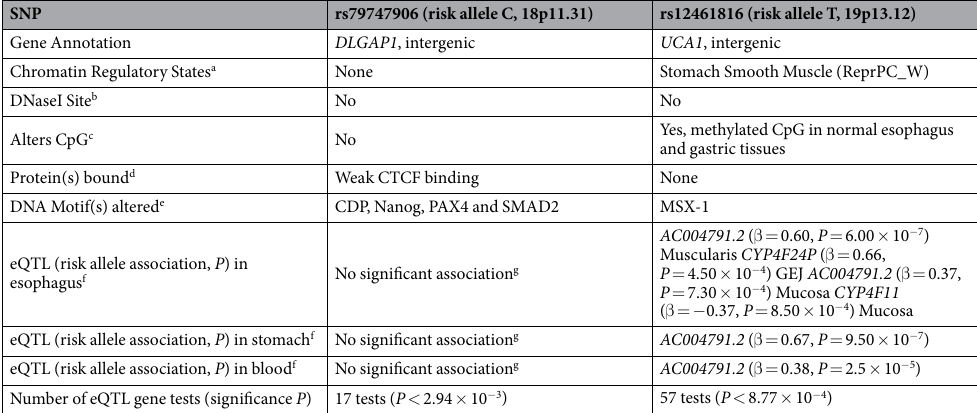
Rs79747906 is located in the intergenic region close to DLGAP1 , SNPs of which have been associated with obsessive-compulsive disorder 19 . Based on Roadmap Epigenomics data rs79747906 does not appear to map to a regulatory region in normal UGI tissues or blood, but the C allele, which was positively associated with FH, overlapped with a weak CTCF binding function in ENCODE cells including Human Esophageal Epithelial Cells (HEEpiC) (Table 3 and SI Figure 1). However, we did not observe potential regulatory function for any SNPs in LD with rs79747906 (r 2 ≥ 0.40, http://analysistools.nci.nih.gov/LDlink/) in normal esophageal tissue (data not shown). We also found that the rs79747906 C allele may alter several DNA binding motifs of homeobox tran- scriptional factors and proteins, including CDP, Nanog, PAX4, and SMAD2 (ENCODE and HaploRegv4) and scores high as a regulatory SNP for embryonic stem and progenitor cells of other tissues (RegulomeDB and HaploRegv4). Collectively, these findings suggest that the genetic region containing rs79747906 has the potential to change chromatin architecture in esophageal epithelia and/or in esophageal stem cells via protein binding. Our eQTL analysis of rs79747906 C allele showed only suggestive and tissue-specific evidence of a potential cis -eQTL effect on transcription, such as increased expression of LPIN2 (more distal protein coding gene) in blood and RP13-270P17.3 (a long intergenic non-coding RNA [LincRNA] gene) in stomach mucosa. It is worth noting that metabolic changes have been reported for UGI cancer patients previously 20, 21 . LPIN2 protein is known for its role in metabolism, with LPIN2 SNPs associated with metabolic traits 22 , which may be important for UGI cancer. Our study provides evidence for future examination of LPIN2 and RP13-270P17.3 and risk of UGI cancer. The T allele of rs12461816 (19p13.12) was associated with FH and can abolish a methylated CpG in normal esophagus and stomach tissues. In keeping with a methylated and condensed DNA status, rs12461816 is also located to a potential polycomb-repressed DNA region in stomach smooth muscle, suggesting a possible tran- scriptional repression function for this region regulated by epigenetics. Notably, rs12461816 T allele was strongly associated with increased expression of AC004791.2 . The expression of multiple other genes with important func- tions may be altered by rs12461816 variant too, such as CYP4F11 , which encodes a cytochrome P450 enzyme (and is important for arachidonic acid or fatty acid metabolism). UGI cancer is a major public health concern worldwide, among the most frequent causes of cancer-related deaths 1, 2 , highlighting the urgent need to elucidate the mechanisms underlying carcinogenesis. We identified potential genetic variants associated with FH of UGI cancer in ESCC cases. Our findings may provide important insights into new low-penetrance susceptibility regions not only for ESCC but possibly for UGI cancer overall,